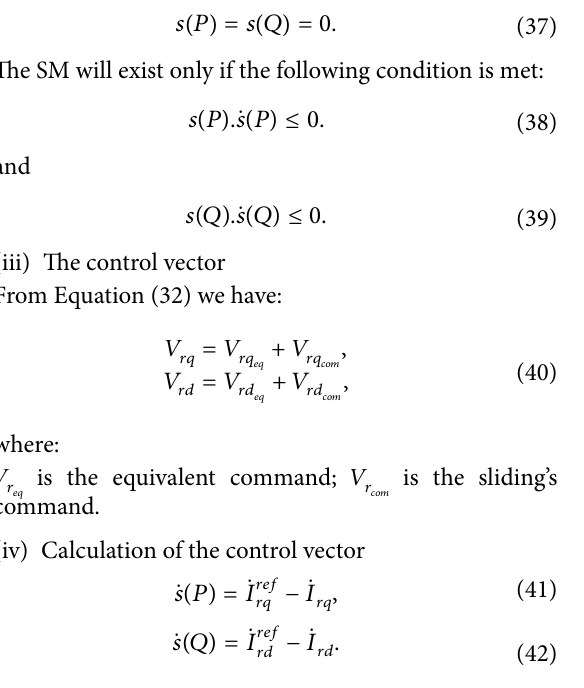
Figure 7: The SM’s